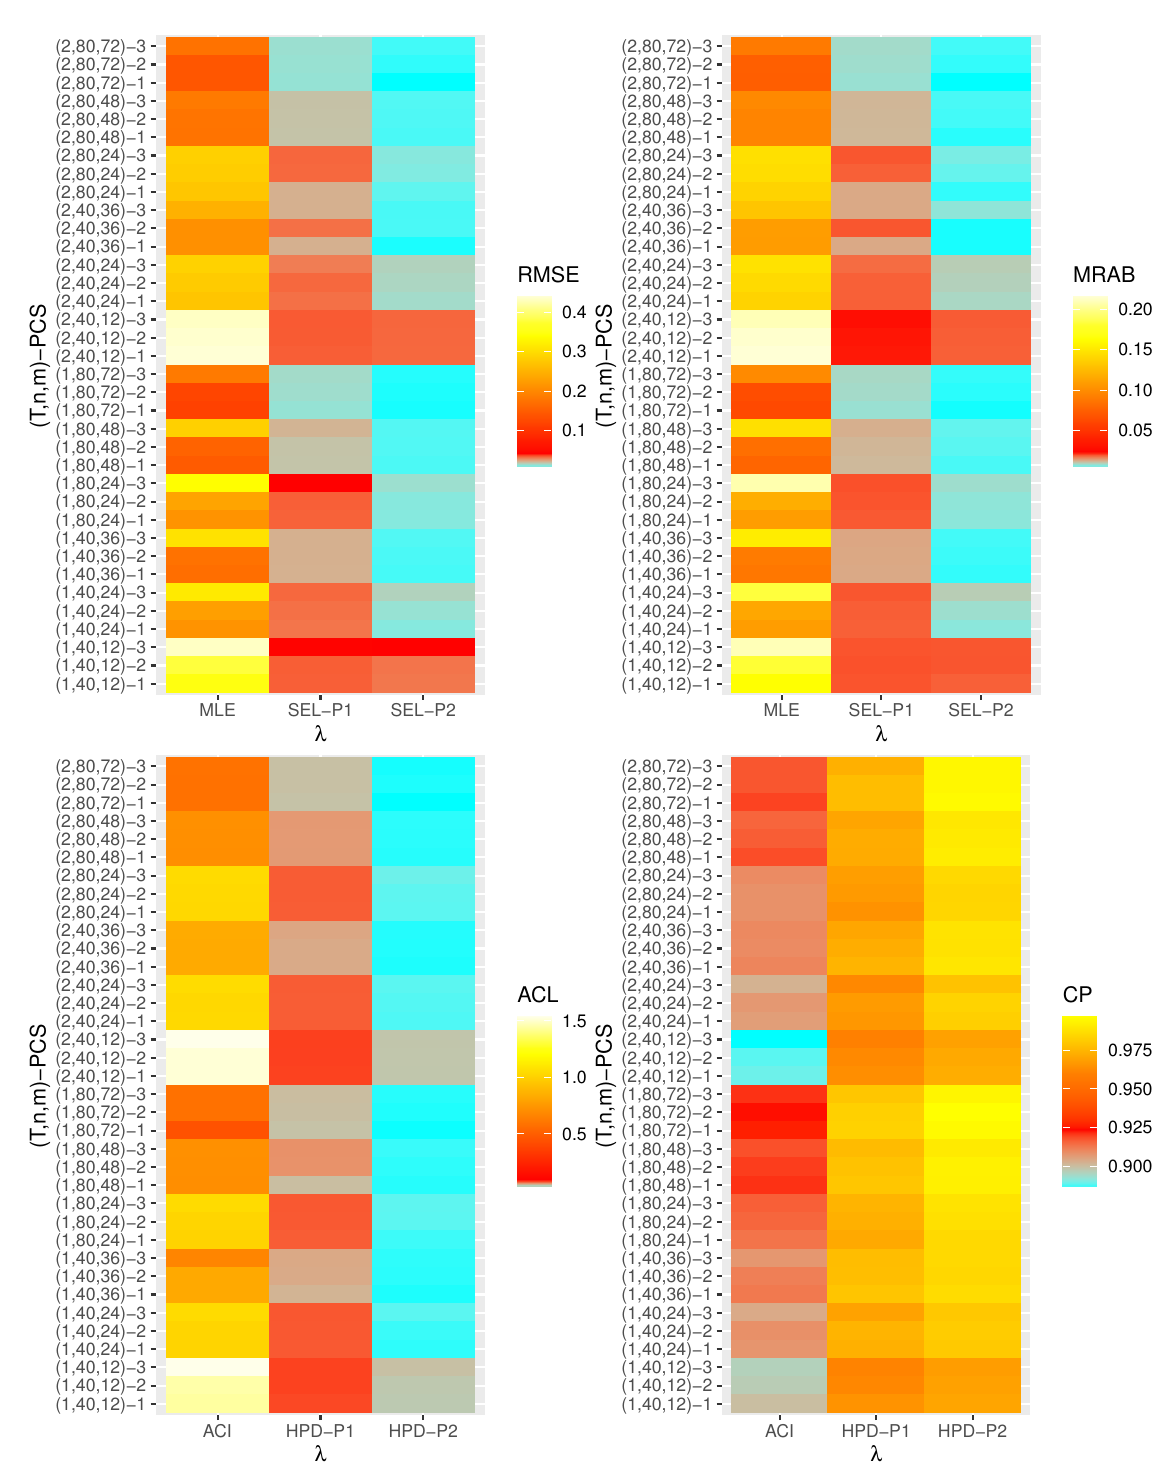
Figure 3. The heatmaps for the estimation results of λ when λ =